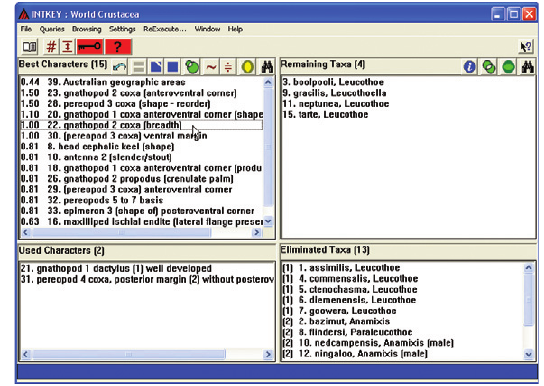
Figure 71. Th e second group of taxa is used to create the dichotomous key.